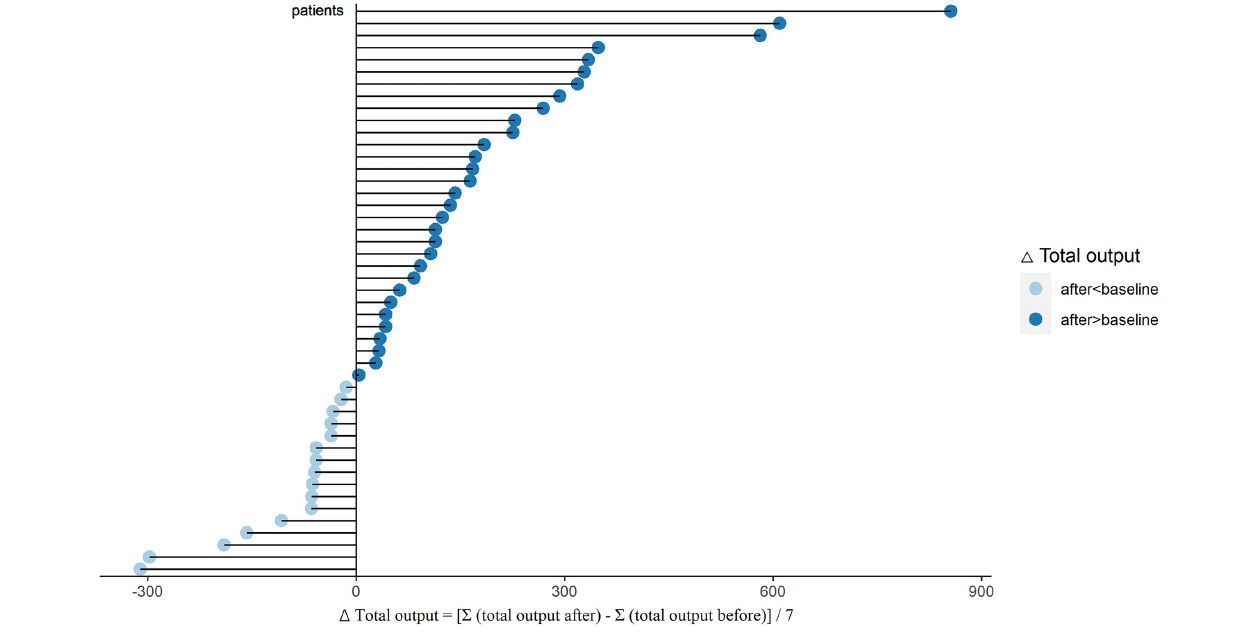
FIGURE 2 | Changes of total output ( 1 Total output) after sacubitril-valsartan initiating in PD patients. Daily total output was collected within 7 days before (total output before) and after (total output after) sacubitril-valsartan treatment. 1 Total output = [ Σ (total output after) – Σ (total output before)]/7. After treated with sacubitril-valsartan, 31 patients had obvious increase of total output (dark blue color), and 16 patients had slight decrease (light blue color). PD, peritoneal